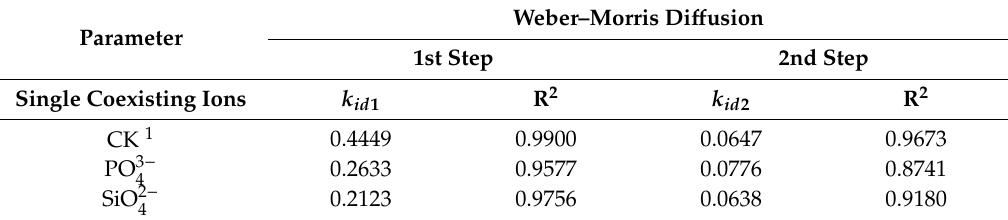
Table 6. Rate constants for the kinetic model of As(V) adsorption on NZVI / AC in the presence of single coexisting